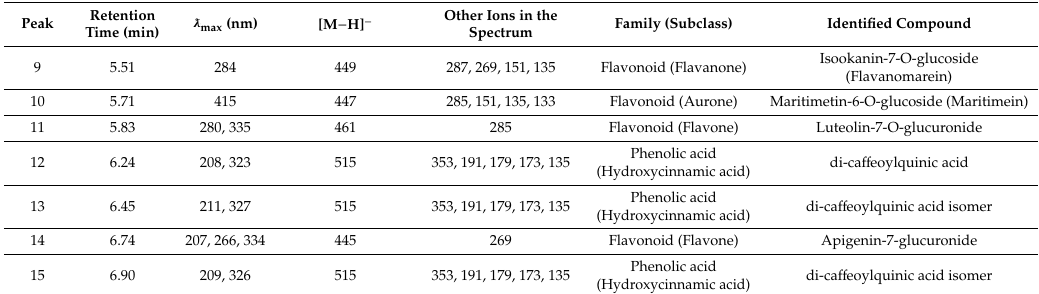
Table 5. Putatively peak identification of the major compounds detected by UHPLC-DAD in the CA extracts. λ max are the local maximum of absorbance on the UV spectrum. [M − H] − column provides the m/z value of the precursor ion. Other ions column gives the m/z value of the fragments that were detected in the MS spectra. Identification method using UV and ESI (-) spectra. Lot number: